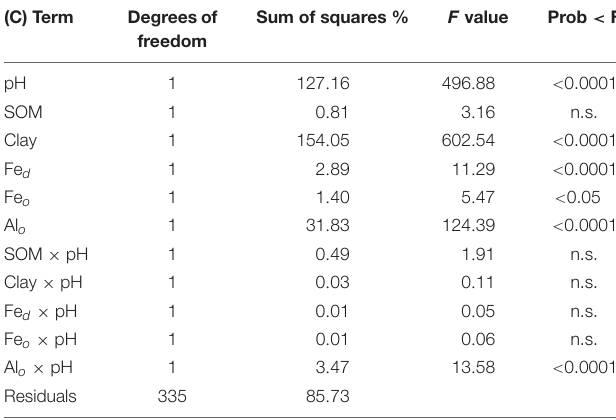
(B,C) Linear mixed effect models testing the effect of SOM, percentage of clay, pH, Fe d , Al o , and Fe o as well as two-way interactions between soil physicochemical properties with pH on CEC eff. in (B) topsoils ( < 30 cm depth) and (C) subsoils ( > 30 cm depth).